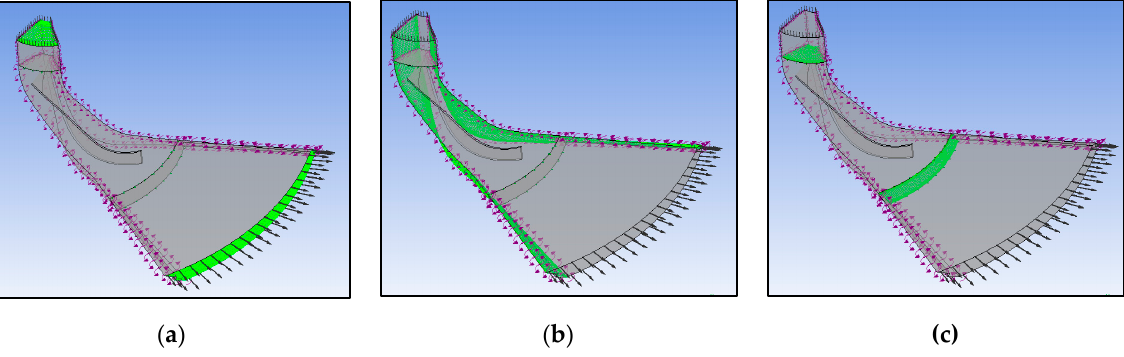
Figure 3. Defined Interfaces for the Inlet and Outlet ( a ), Periodic Boundaries ( b ) and Frozen Rotor Frame Change from the Inlet to Impeller and Impeller to Outlet ( c ).